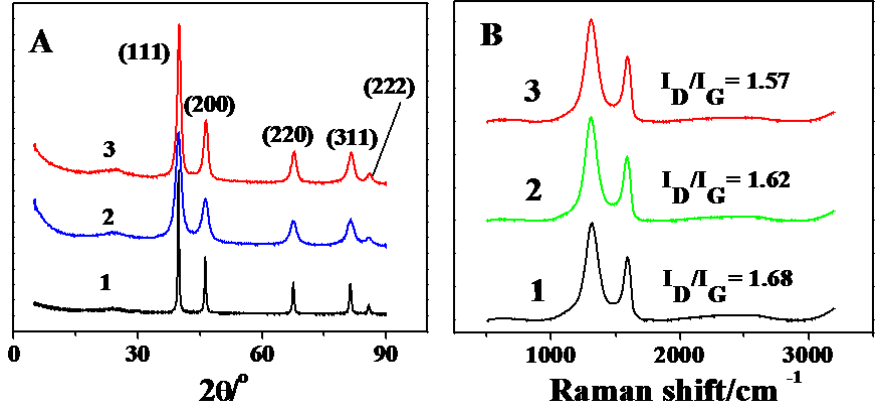
Figure 3. XRD patterns ( A ) and Raman spectra ( B ) of Pt/GNs ( 1 ), Pt/GNs (CS) ( 2 ), and Pt/GNs(PAMAM) ( 3 ).